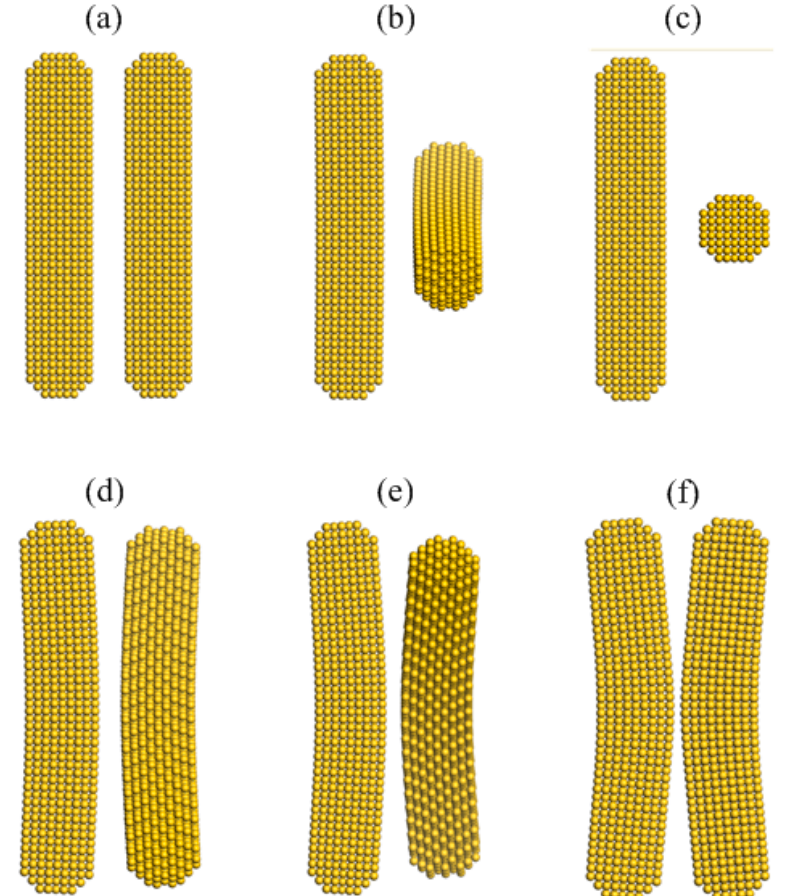
Figure 2. Snapshots of a pairwise identical AuNRs side-by-side with a diameter of 2 nm and an aspect ratio of 5 during their dynamics interacting process: ( a ) 0 ps, ( b ) 0.89 ps, ( c ) 10.1 ps, ( d ) 14.6 ps, ( e ) 20 ps, and ( f ) 21.59 ps.